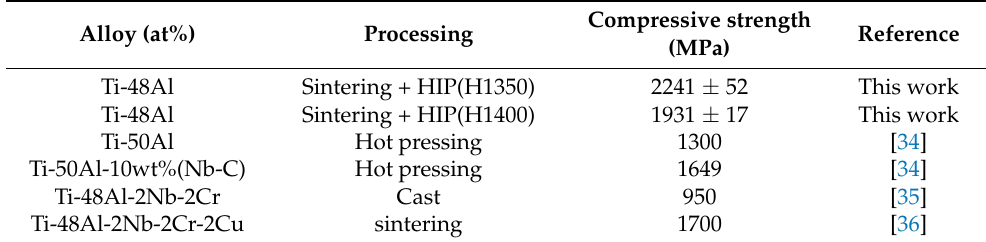
Table 4. Compression properties of TiAl alloys in this work and other reports.